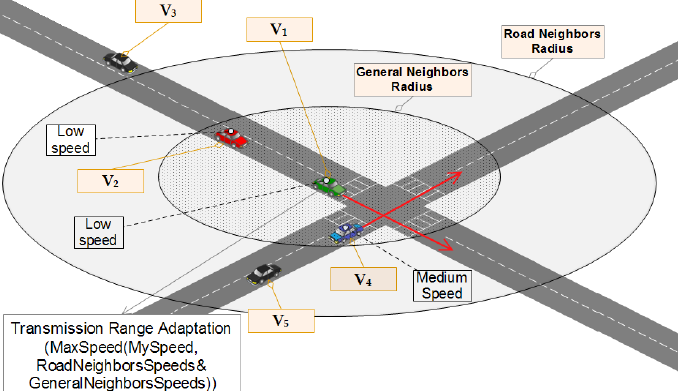
Figure 7. WHISPER behavior in the presence and influence of general neighbors on the transmission range adjustment.